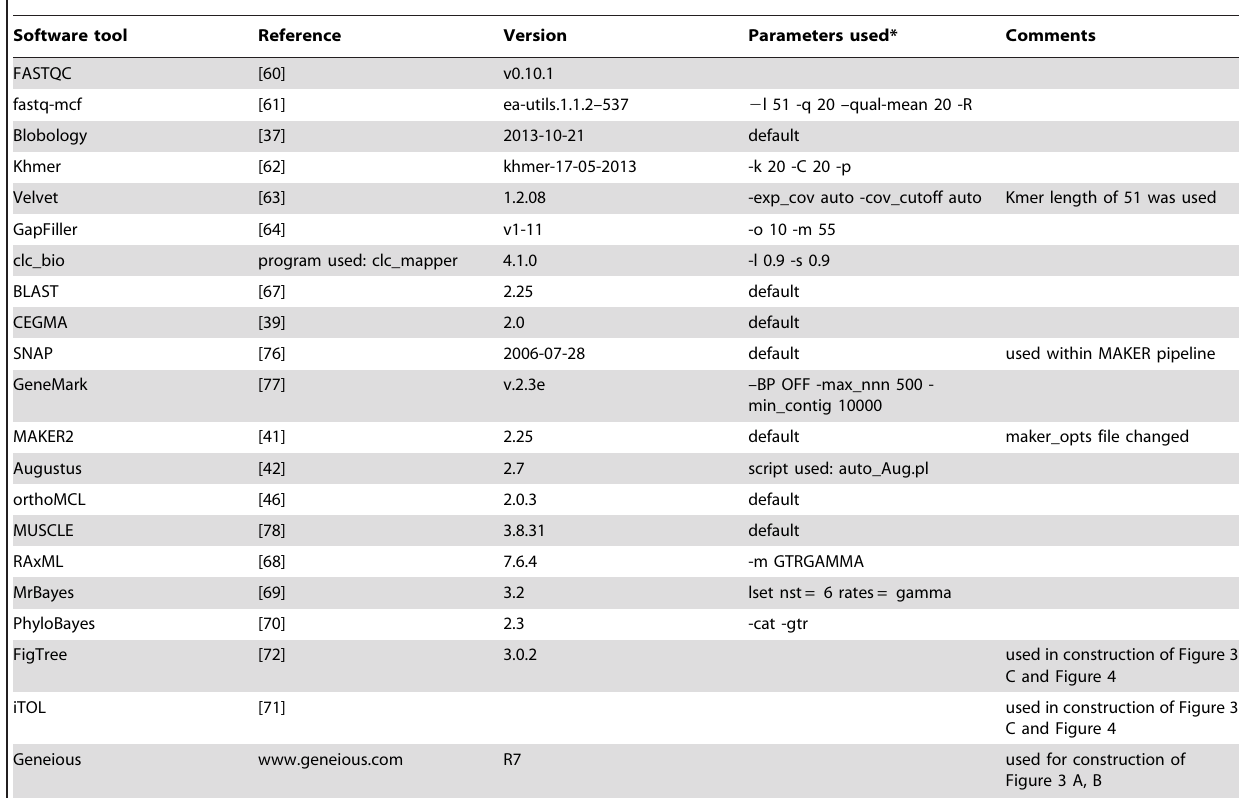
Table 6. Analysis software versions and parameter settings.